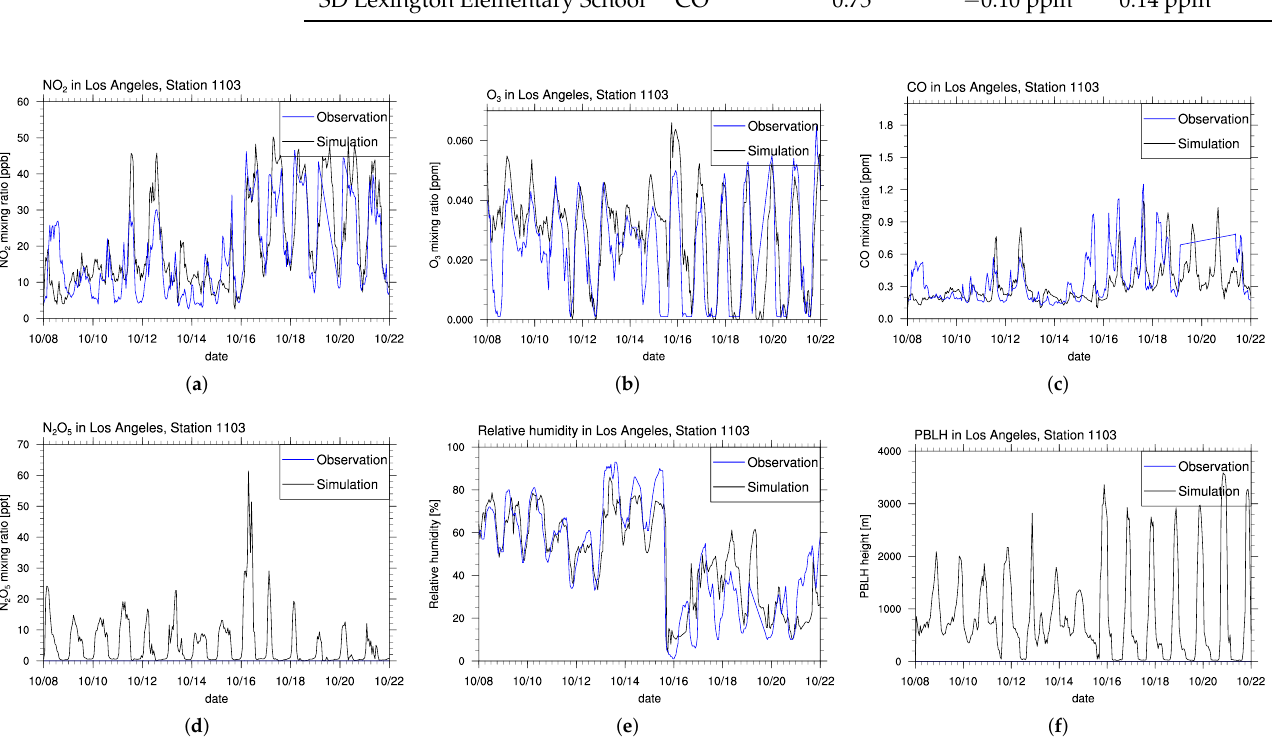
Figure 9. Comparison of in situ measurements with modeled variables at the ground at LA North Main Street in October 2018. No measurements for N 2 O 5 and the planetary boundary layer height are